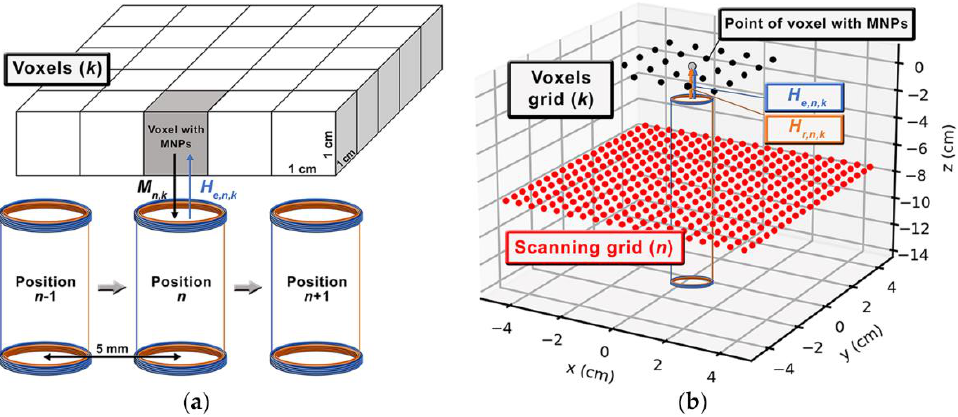
Figure 2. Schemes of sensitivity matrix ( L ) acquisition using: ( a ) the experimental and ( b ) calculated ACB single-channel scanning approach.